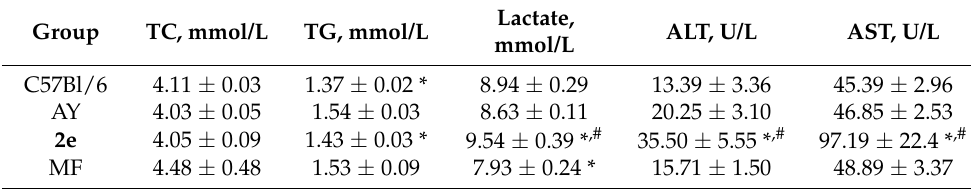
Figure 4. ( A ) OGTT results. The test conducted after 28 days of AY mice treatment using com- pound 2e . ( B ) AUC calculated according to the OGTT data after 28 days of AY mice treatment using compound 2e . Doses: 2e —15 mg/kg, MF—250 mg/kg. * p < 0.05 as compared to AY mice, # p < 0.05 as compared to MF. Table 4. Blood biochemical parameters at the end of the experiment. TC—total cholesterol, TG— triglycerides, ALT—alanine aminotransferase, AST—aspartate transaminase. * p < 0.05 as compared to AY mice, # p < 0.05 as compared to